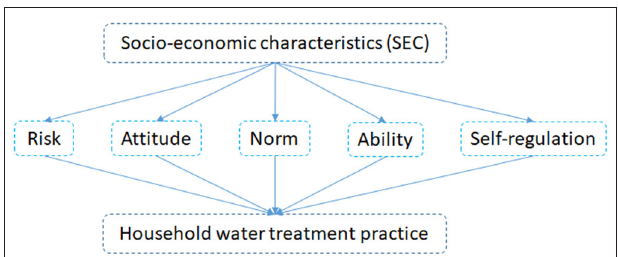
FIGURE 2 | A conceptual model of the three-level hierarchical BBN